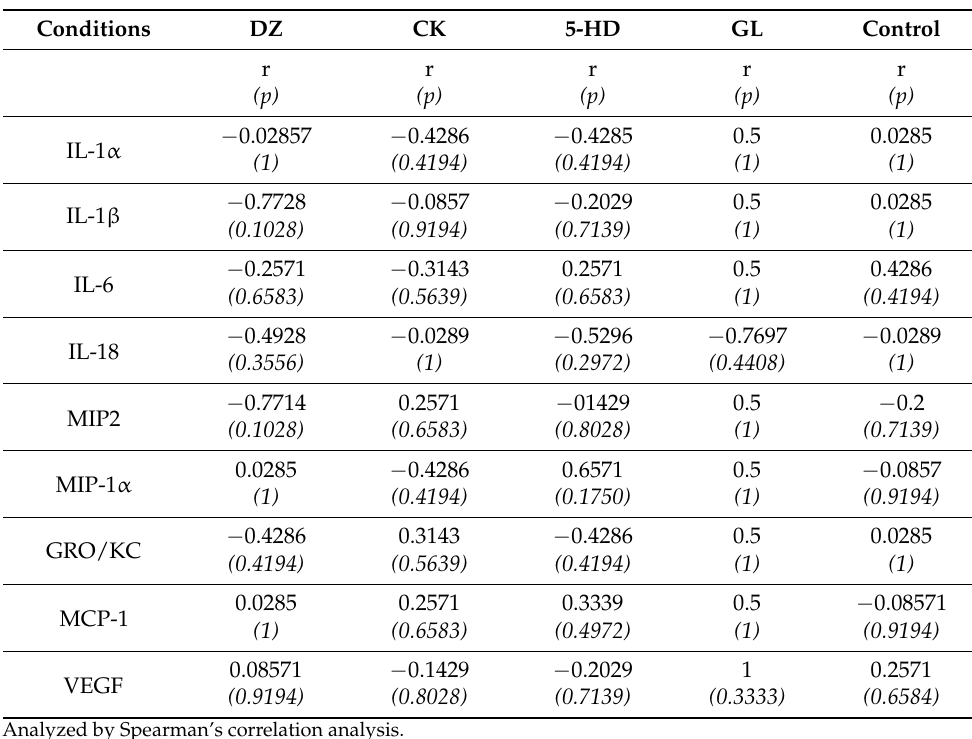
Table 1. Correlation between tissue carbonyl protein contents and perfusate cytokine levels.